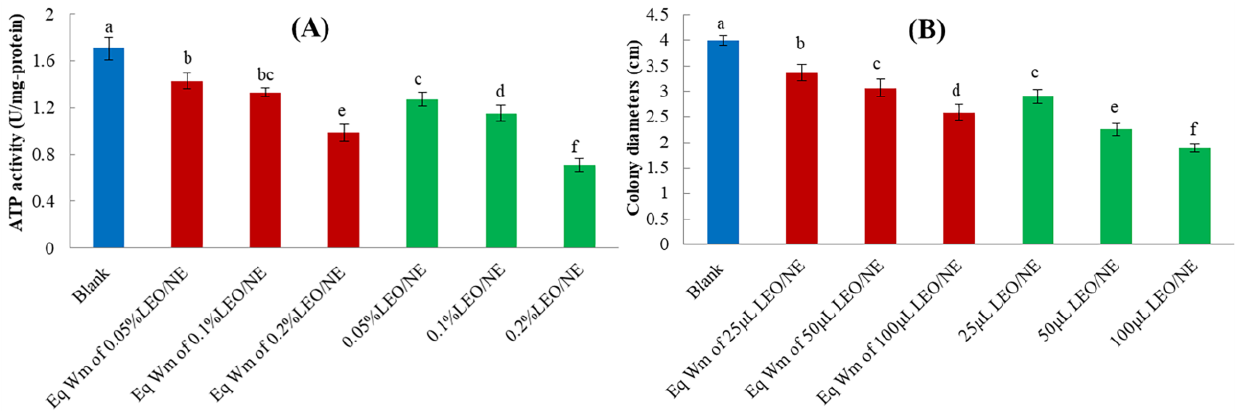
Figure 3. The effect of lemon essential oil nanoemulsion (LEO/NE) and equivalent wall material (Eq Wm) on the intracellular ATPase ( A ) and colony diameters ( B ) of Phomopsis sp. Different letters above each column of indicate significant differences.